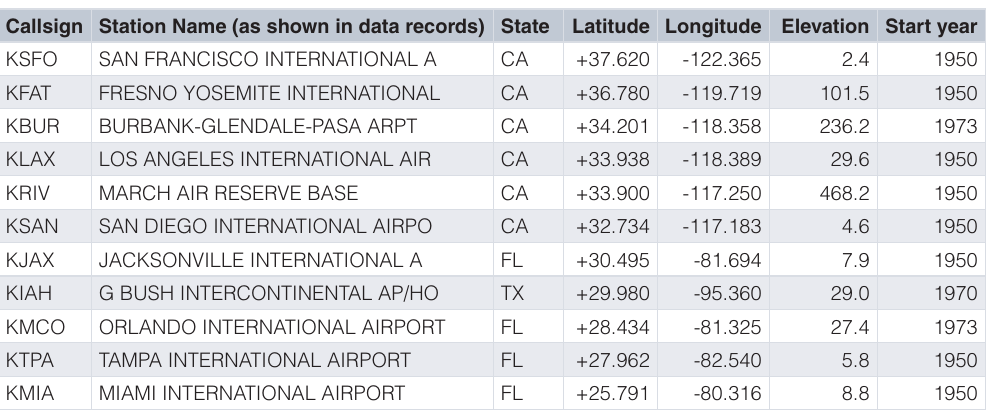
Table 1. Weather station sites used (NOAA